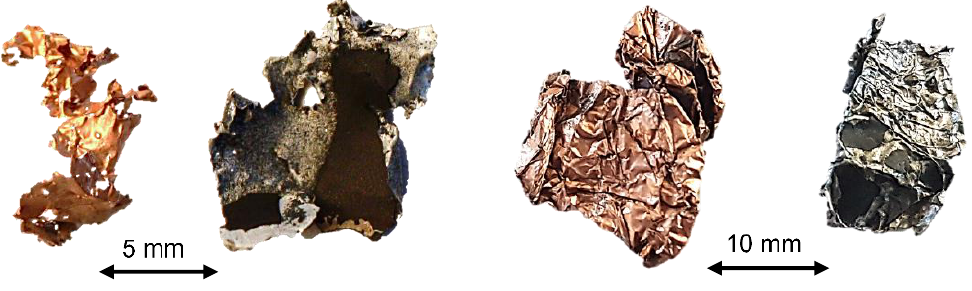
Figure 11. Representative foil pieces after EHF stress ( left ) and after comminution in the granulator ( right ).